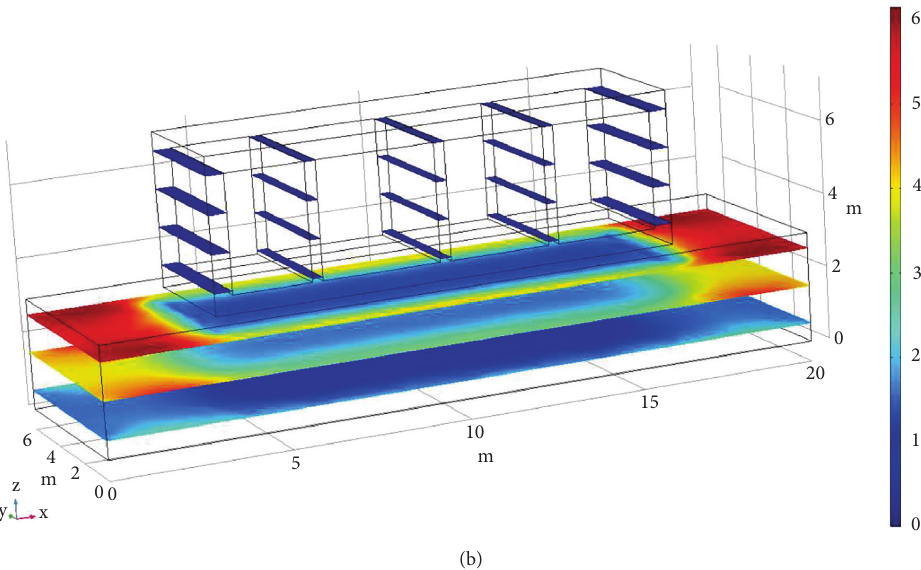
Figure 8: Map of displacement distribution characteristics. (a) Overall view. (b) Slice